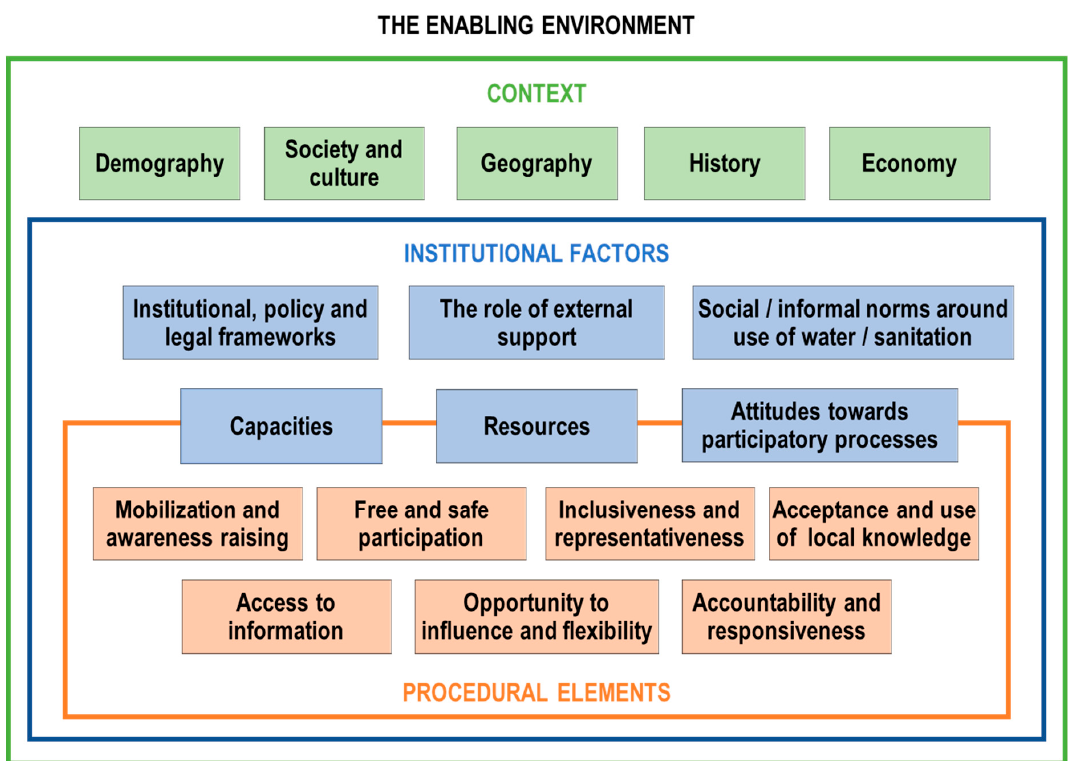
Figure 1. The enabling environment for meaningful participation.